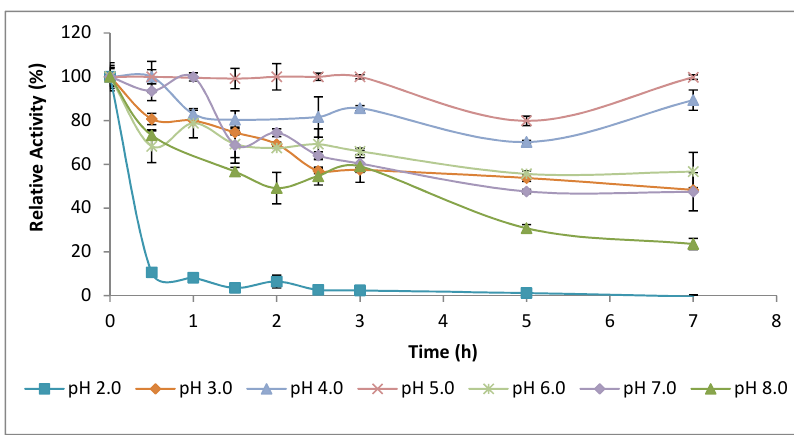
FIGURE 3 - Relative stability of bromelain in several pH at 40 °C. The error bars refer to standard deviation.